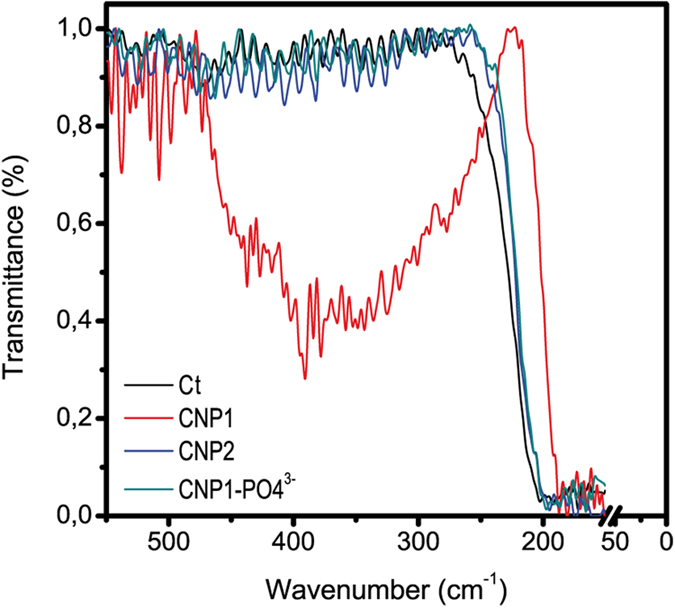
FTIR transmission profiles of P. subcapitata control cells (Ct), CNP1, CNP2 and CNP1-PO43−.Wavenumber range: 550–50 cm−1.